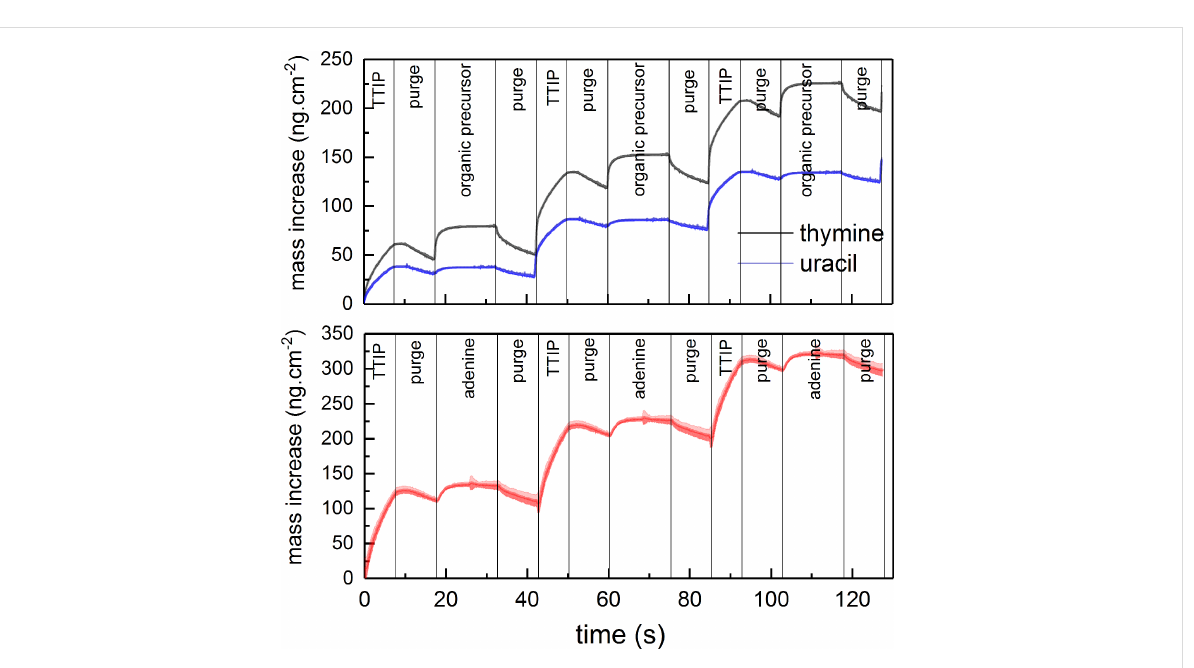
Figure 3: Evaluation of mass increase during growth by QCM using TTIP and thymine (at 225 °C), uracil (at 225 °C) (top graph), or adenine (250 °C) (bottom graph). The shaded area represents the standard deviation during 16 cycles, where the noise in the middle of the adenine pulse stems from edge effects of the